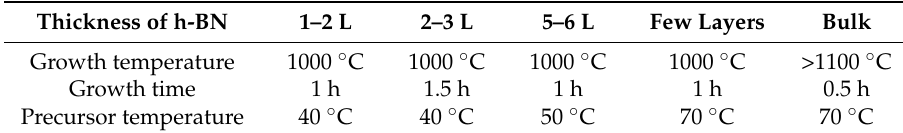
Table 1. Specific growth conditions of h-BN films in various layers.